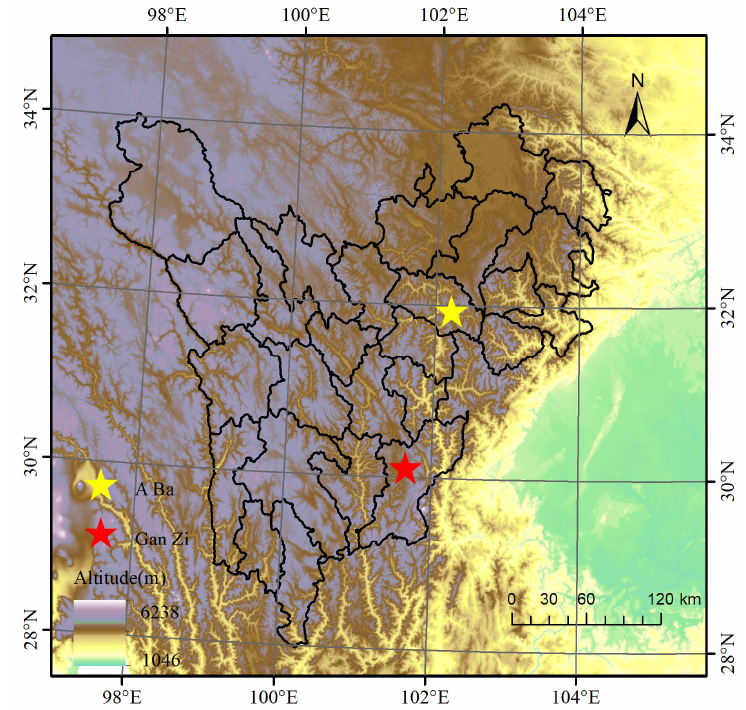
Figure 1. Topographic map of western Sichuan, China.